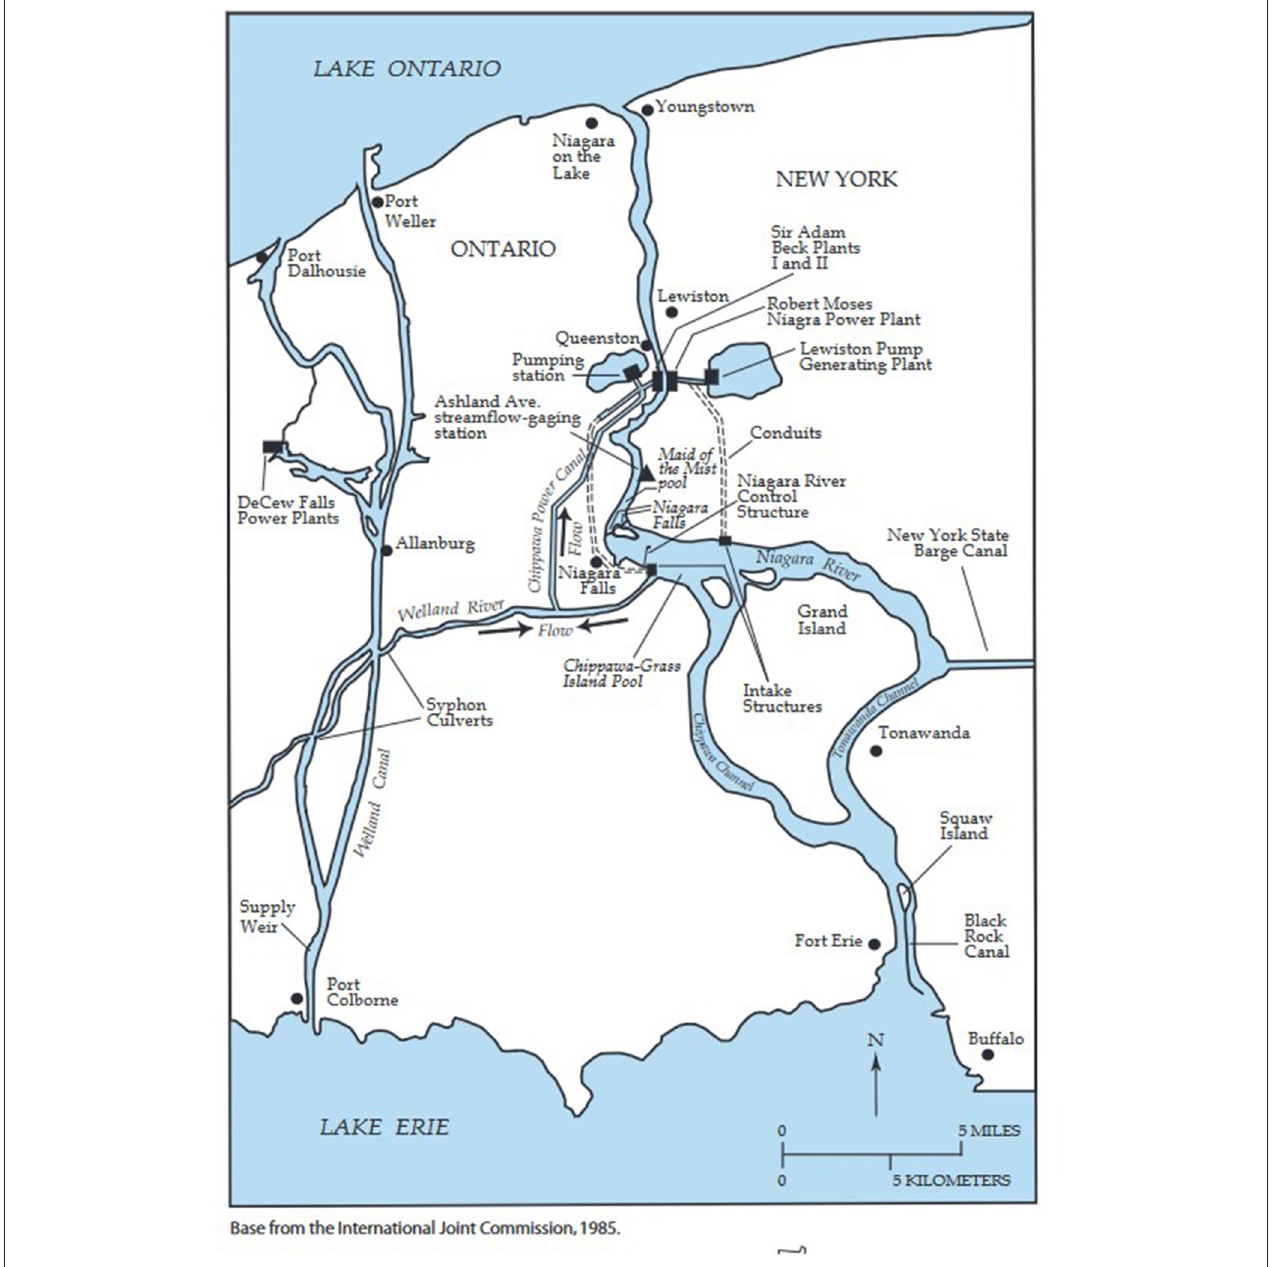
FIGURE 6 | Map of the Niagara River and Welland Canal [source: Neff and Nicholas